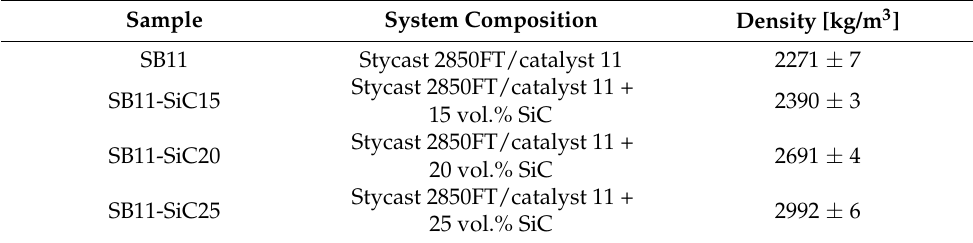
Table 1. Overview of the tested composite